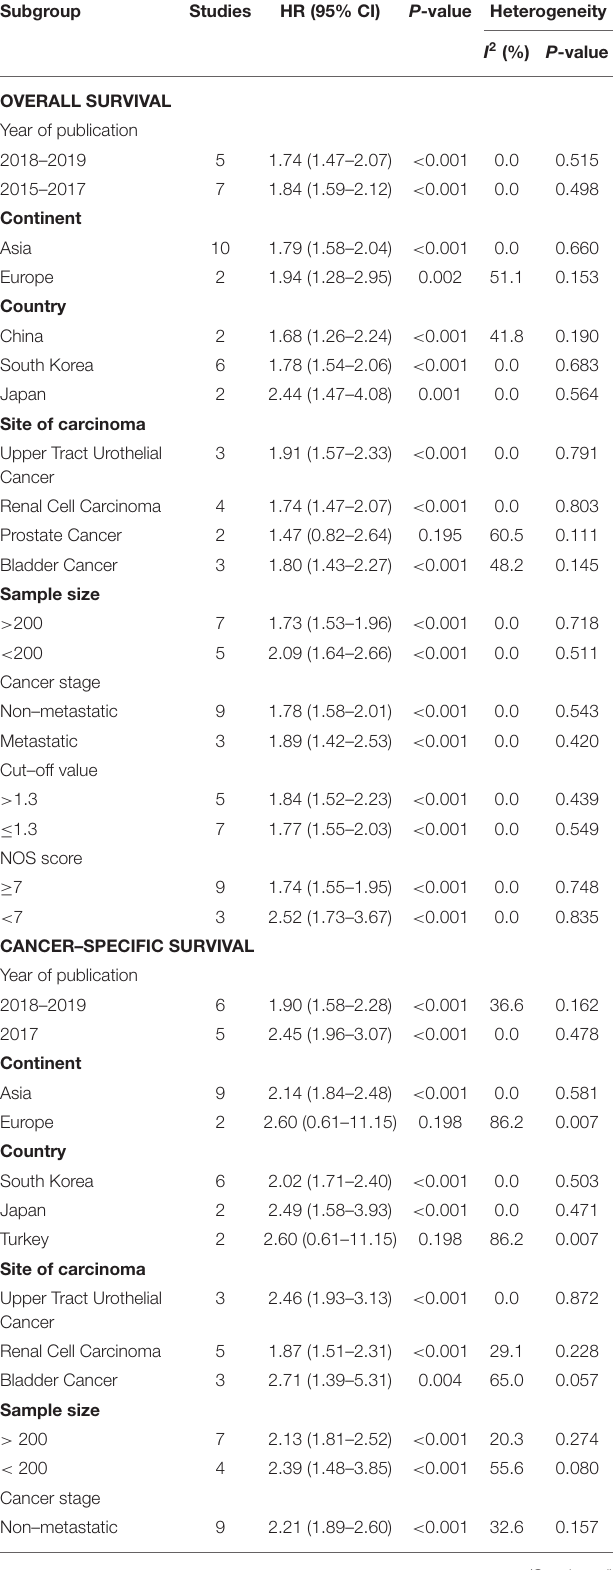
TABLE 2 | Subgroup analysis of overall survival and cancer-specific survival.